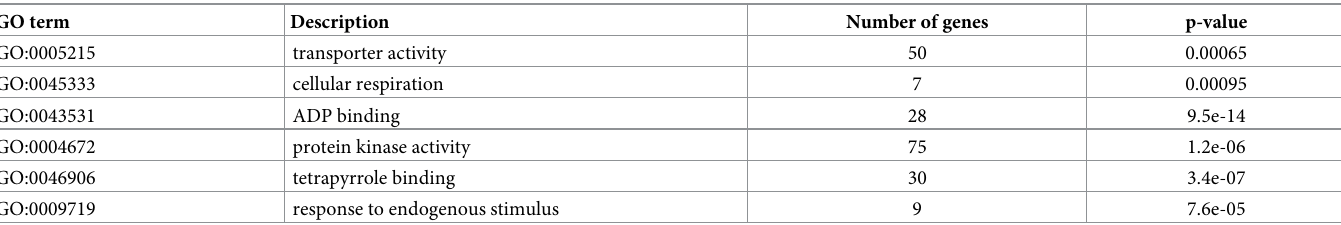
Table 4. GO enrichment analyses of up-regulated genes in G . hirsutum Li 1 and Li 2 short fibers at PCW stage. List and annotation of genes are described in S5 Table. GO